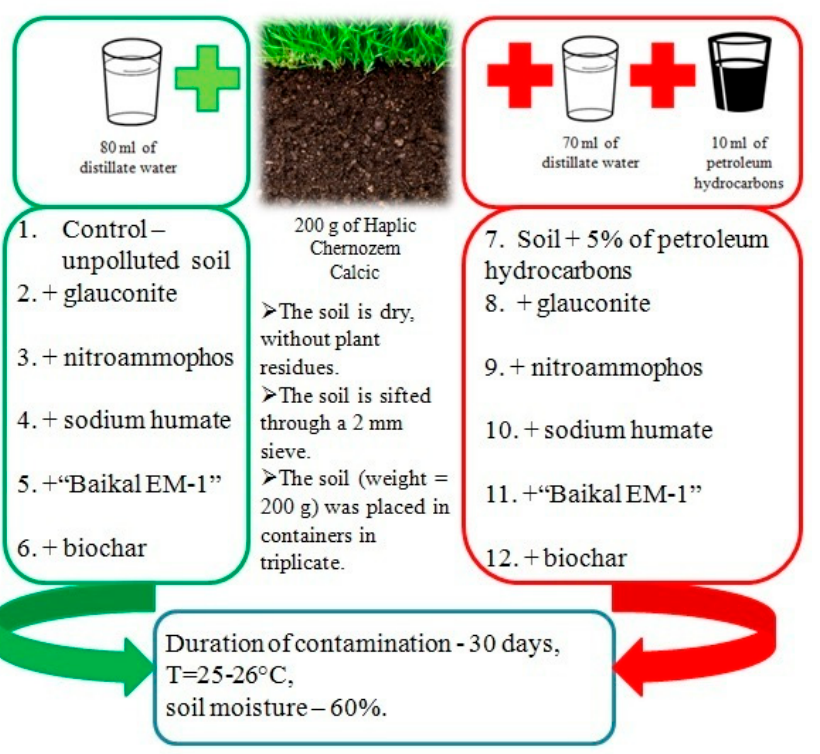
Figure 5. Model experiment on bioremediation of Haplic Chernozem Calcic contaminated with petroleum hydrocarbons.